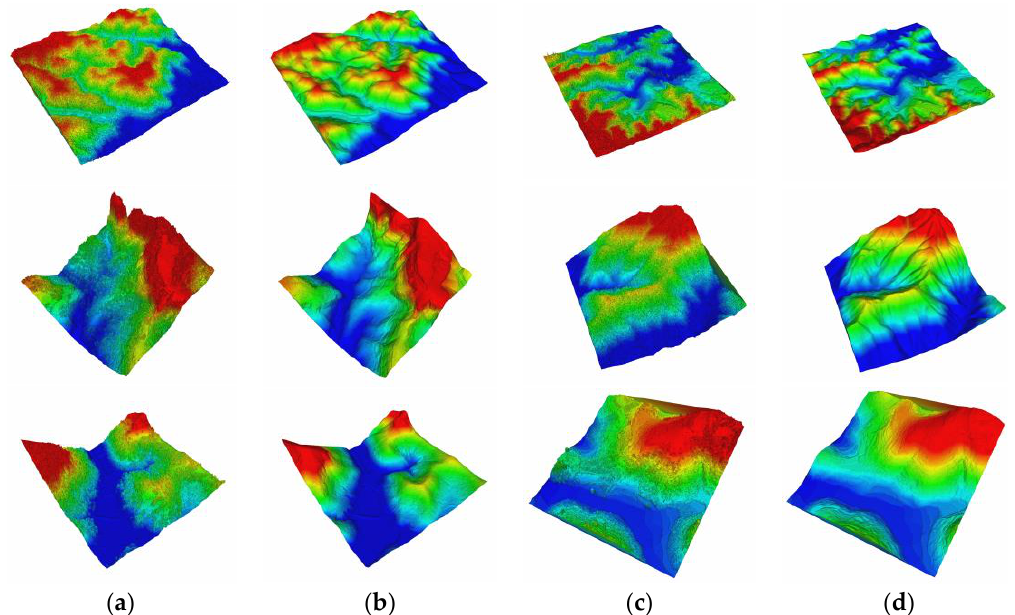
Figure 7. ( a , c ) Elevation rendering of DSM and ( b , d ) manual extraction DEM of dataset III.